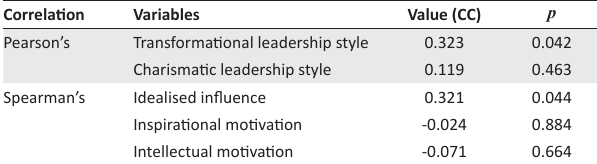
TABLE 5: Self-concept external motivation, transactional and charismatic leadership style.